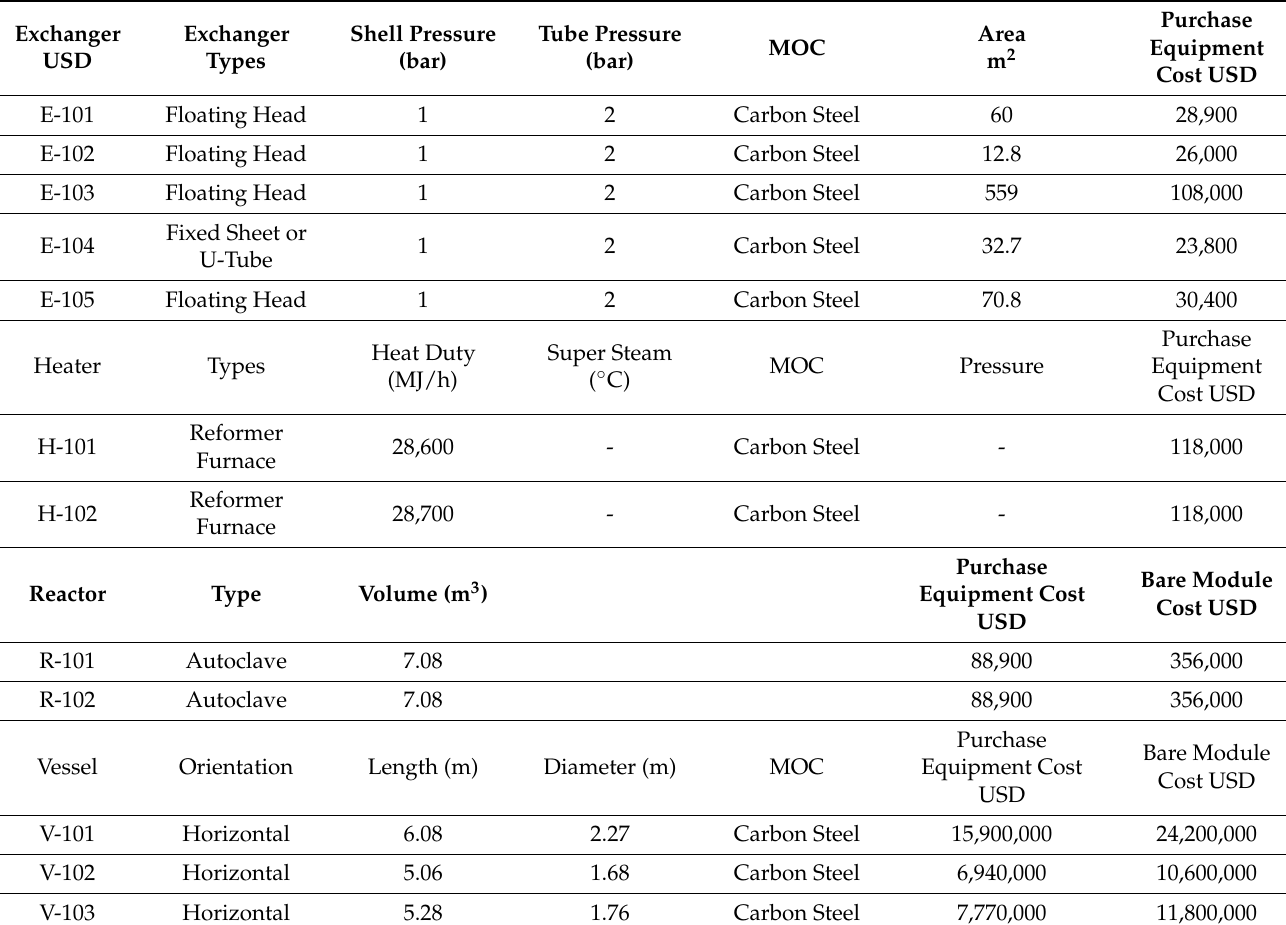
Table 12. Cost analysis of the Claus process after pinch analysis.